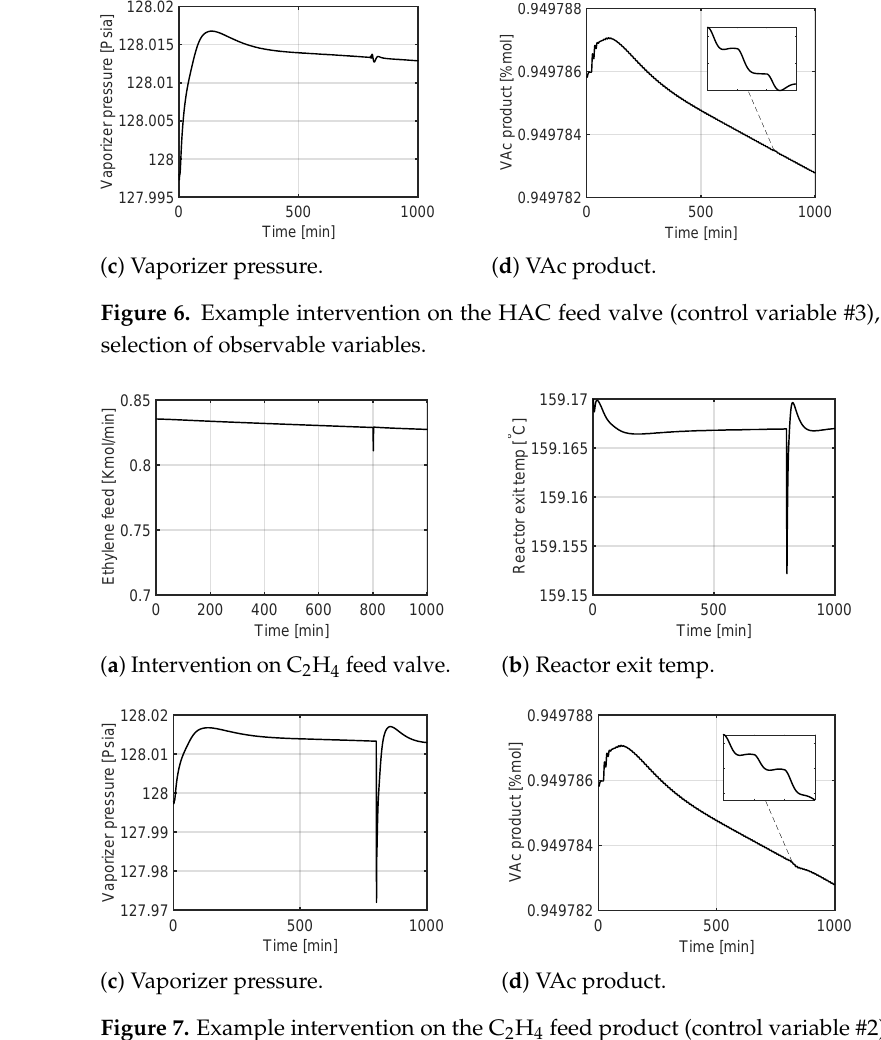
Figure 7. Example intervention on the C 2 H 4 feed product (control variable #2) and its impact on a selection of observable